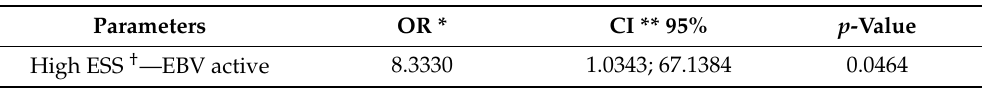
Table 5. Adjusted analysis of variables associated with the EBV lytic infection profile of patients with other AIRD ( n =